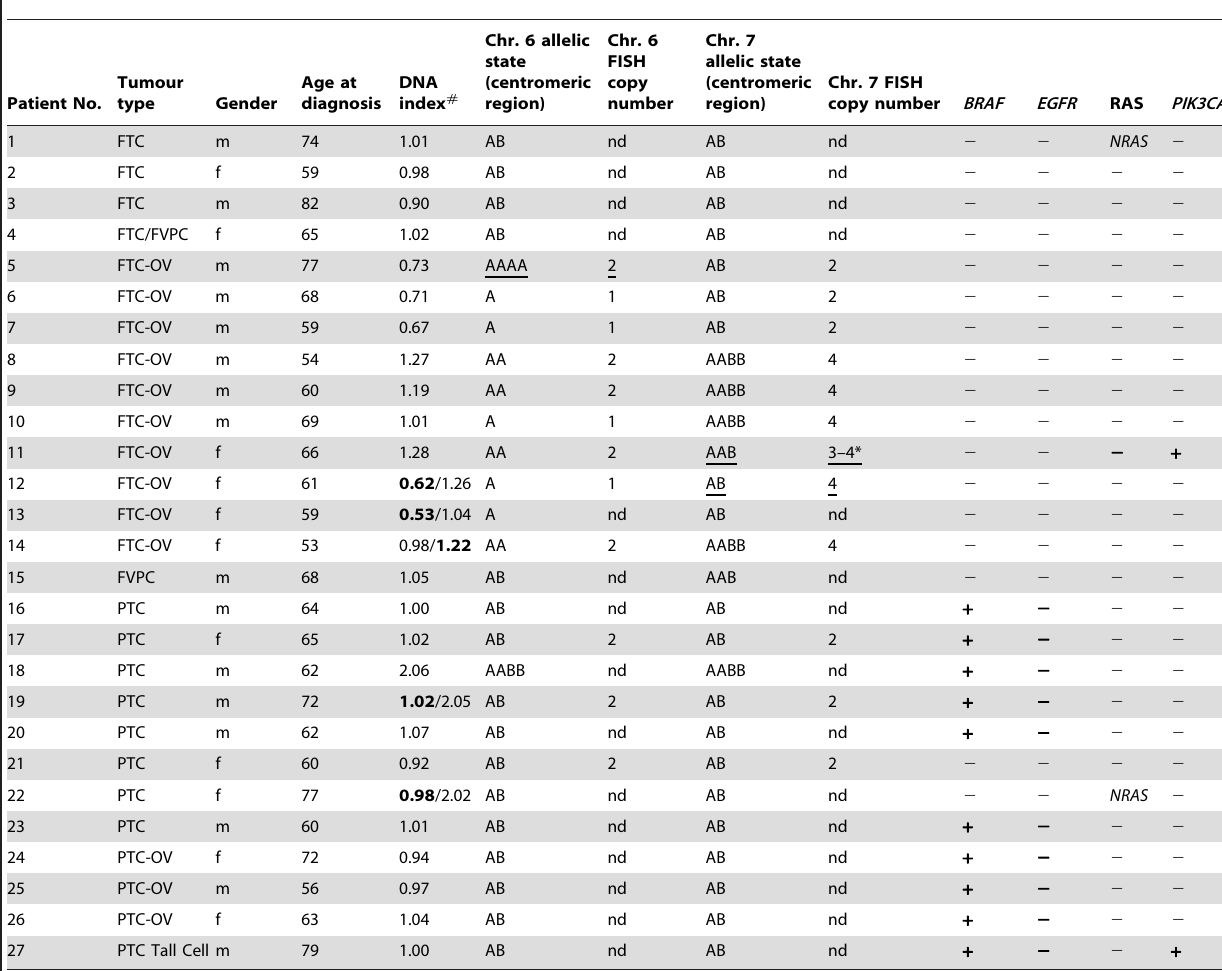
Underlined: discrepancy between FISH copy number and allelic state. # =bold indicates the dominant population as determined by flow cytometry, in cases where multiple populations are present. *=an intermingled pattern of three and four copies was found both for the centromeric and the EGFR locus specific probes. + =presence of mutation. 2 =mutation not found. nd=not